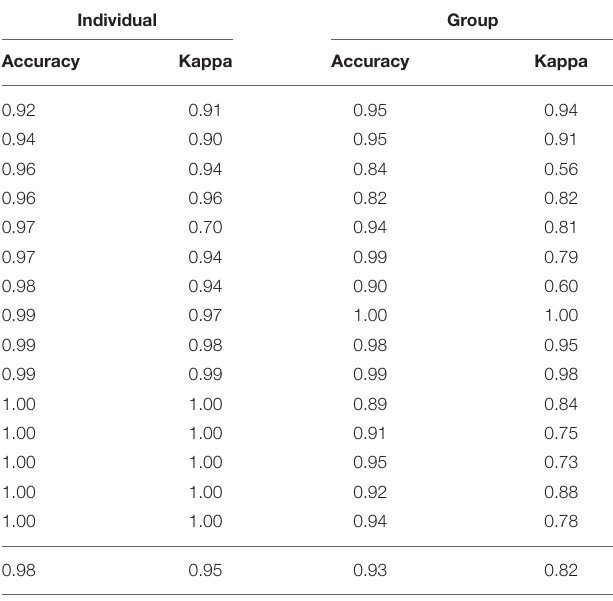
TABLE 1 | Unweighted, overall accuracy, and Cohen’s Kappa for each individual participant in the lab validation study.